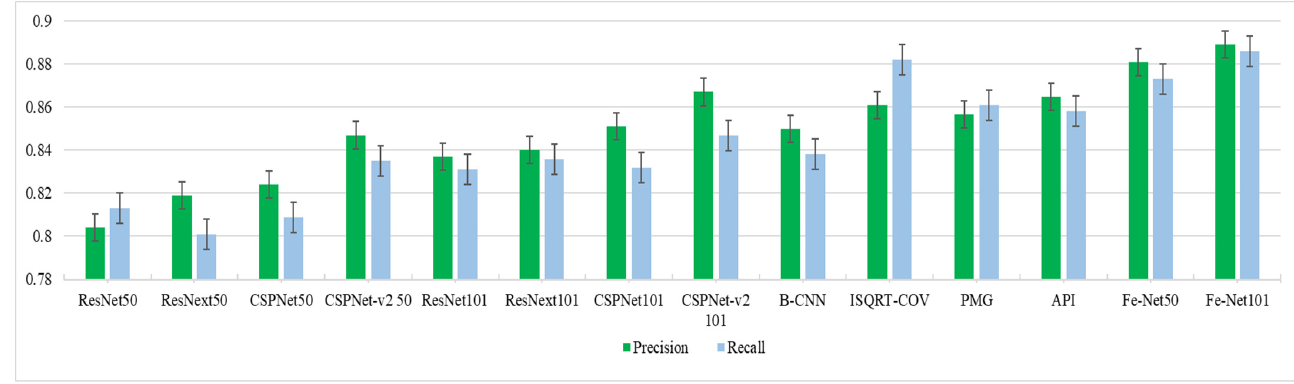
Table 2. Ablation experiment of Fe ‐ Net.